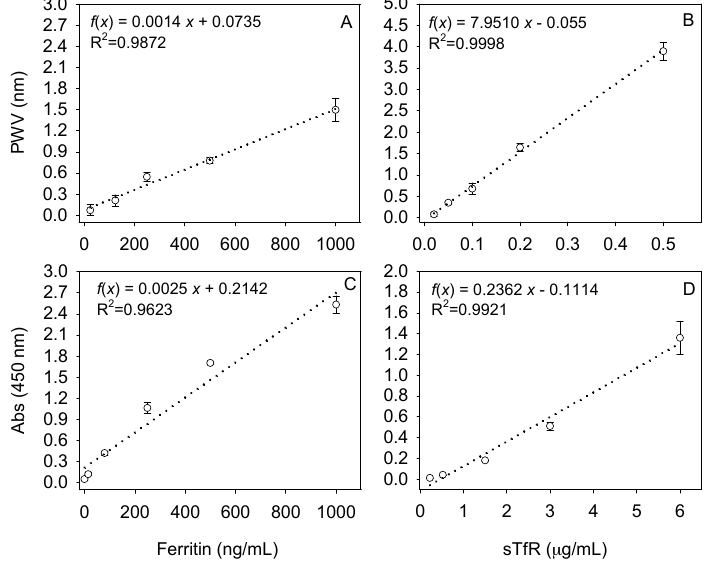
Figure 1. Standard curves for ferritin (left) or soluble transferrin receptor (sTfR; right) on ( A , B ) the photonic crystal (PC) biosensor or ( C , D ) certified enzyme-linked immunosorbent assays (ELISAs). PWV: peak wavelength value.